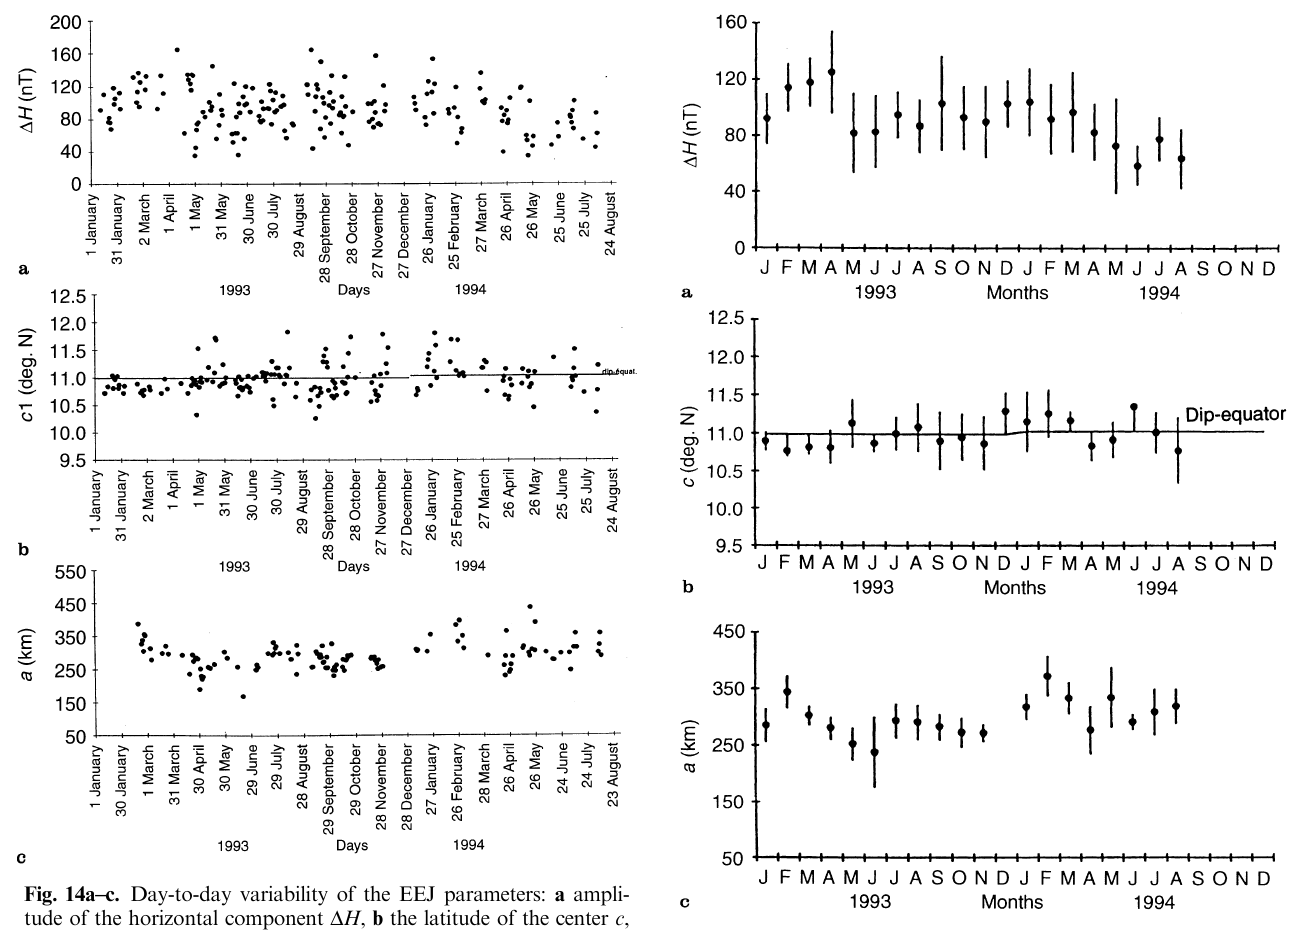
of the horizontal component (cid:68) H , b the latitude of the center c , and c the half-width a , based on the monthly means, with corresponding